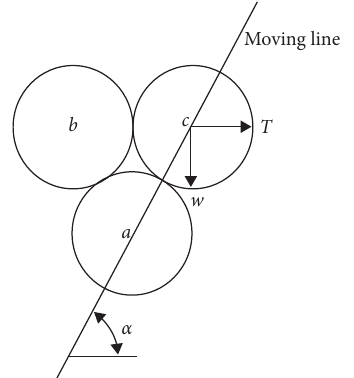
Figure 6: Analysis diagram of movement boundary of the loose